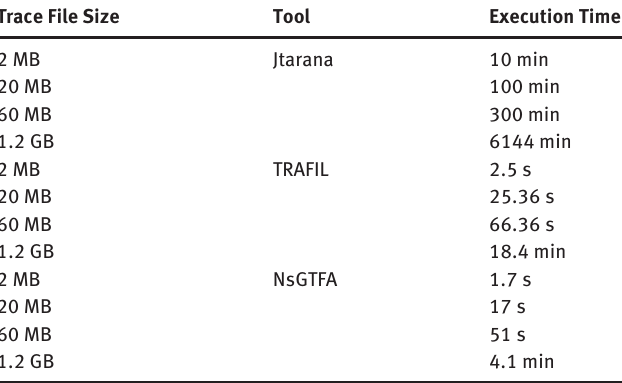
Table 1. Processing Time Results.